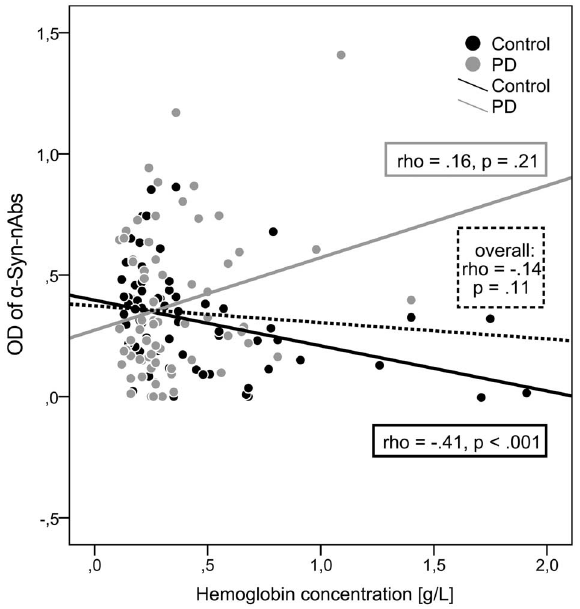
Figure 2. Scatterplot and Spearman correlations (rho, p-values) of a -Syn-nAbs OD and hemoglobin concentrations for the overall sample and separately for healthy controls (black dots/line) and PD patients (grey